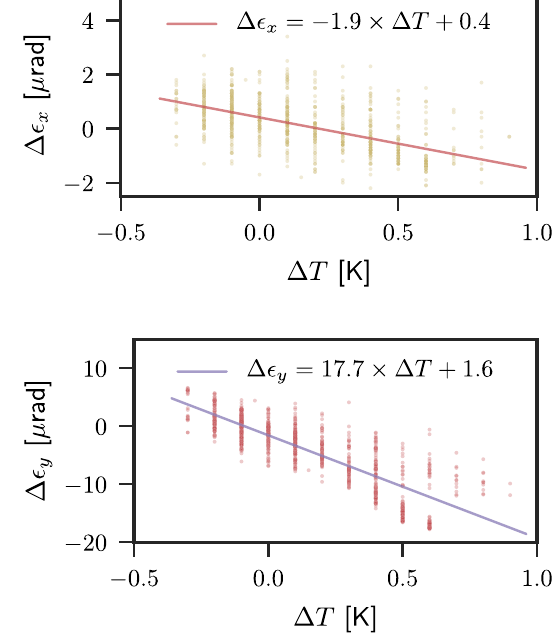
FIG. 11. MPS beam angle deviation as function of the air temperature measured near the body of the MPS. The working temperature was 24 °C. The data have been obtained by cycling many times around the working